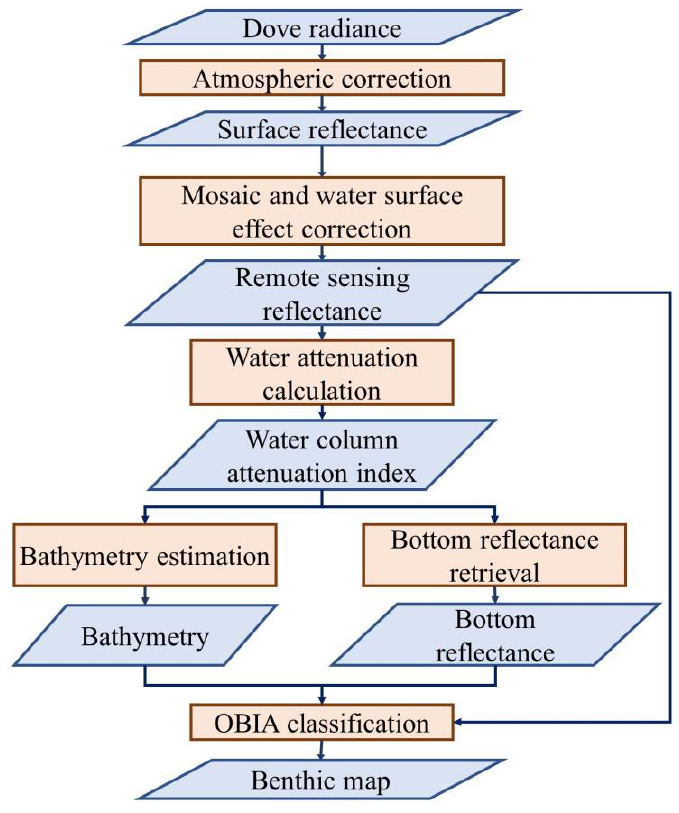
Figure 2. Bathymetric, bottom reflectance, and benthic map retrival.